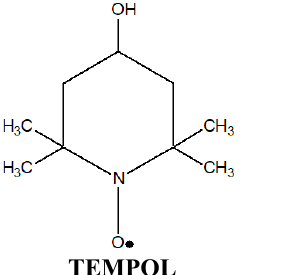
Figure 1. Structures of the used spin probes.